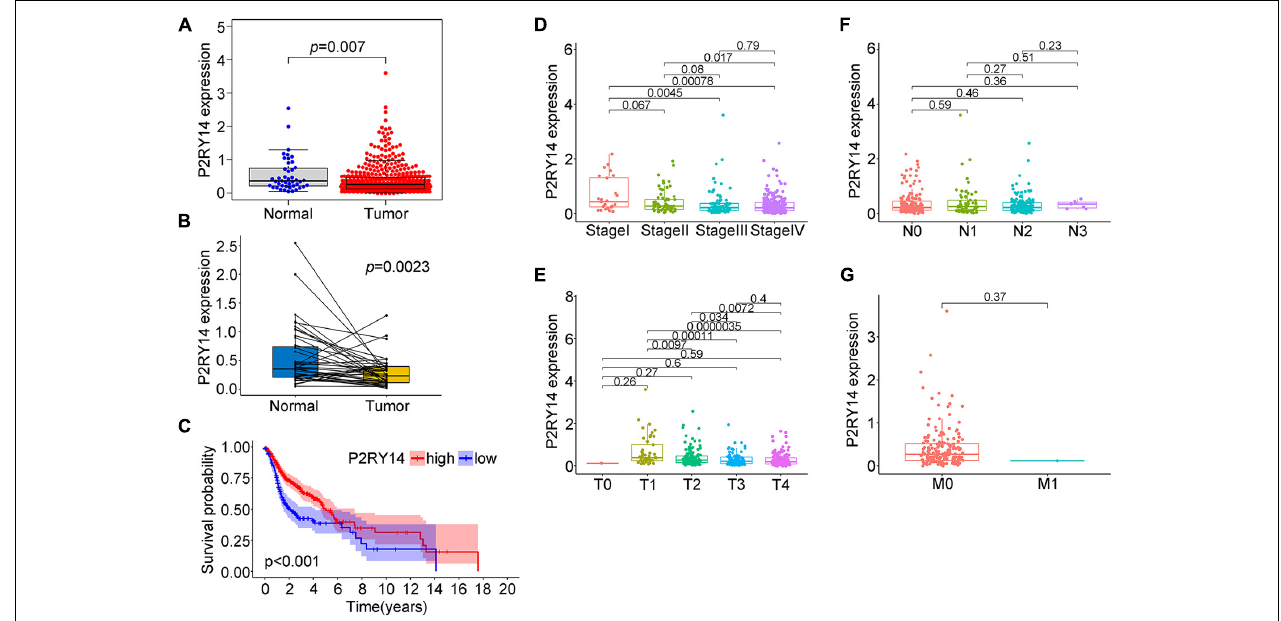
FIGURE 4 | Expression of P2RY14 in samples of HNSC patients from the TCGA database and its correlation with survival and TNM staging distribution. (A) Differentiated expression of P2RY14 in normal and tumor samples. (B) Paired differentiation analysis of P2RY14 in the normal and tumor sample derived from the same patient. (C) Survival analysis for HNSC patients with different P2RY14 expression. (D–G) Distribution of P2RY14 expression level in clinical stage, T classification, N classification, and M